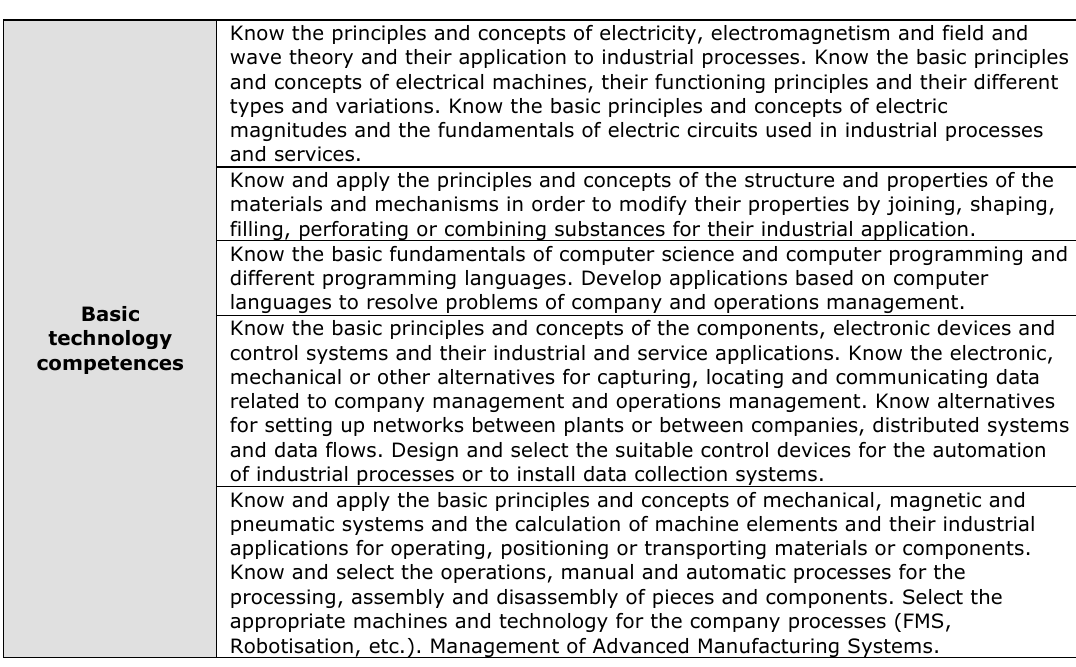
Table 1b. “General